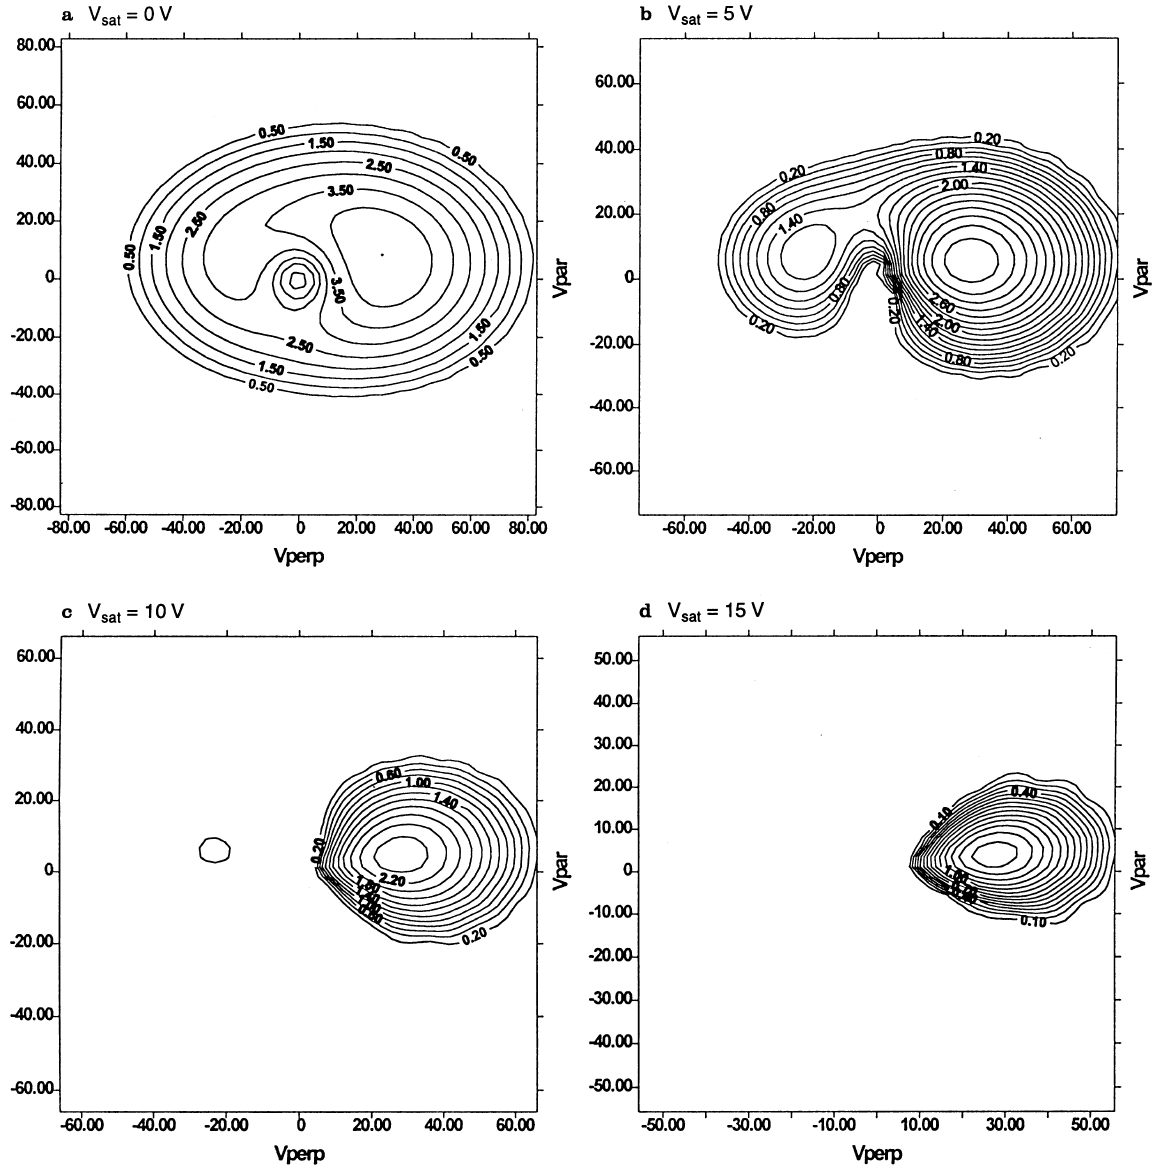
Fig. 8a–d. Some results of the model calculations for ion distribution functions (see text); v and perpendicular to the magnetic field in km s –1 . Labels are in log